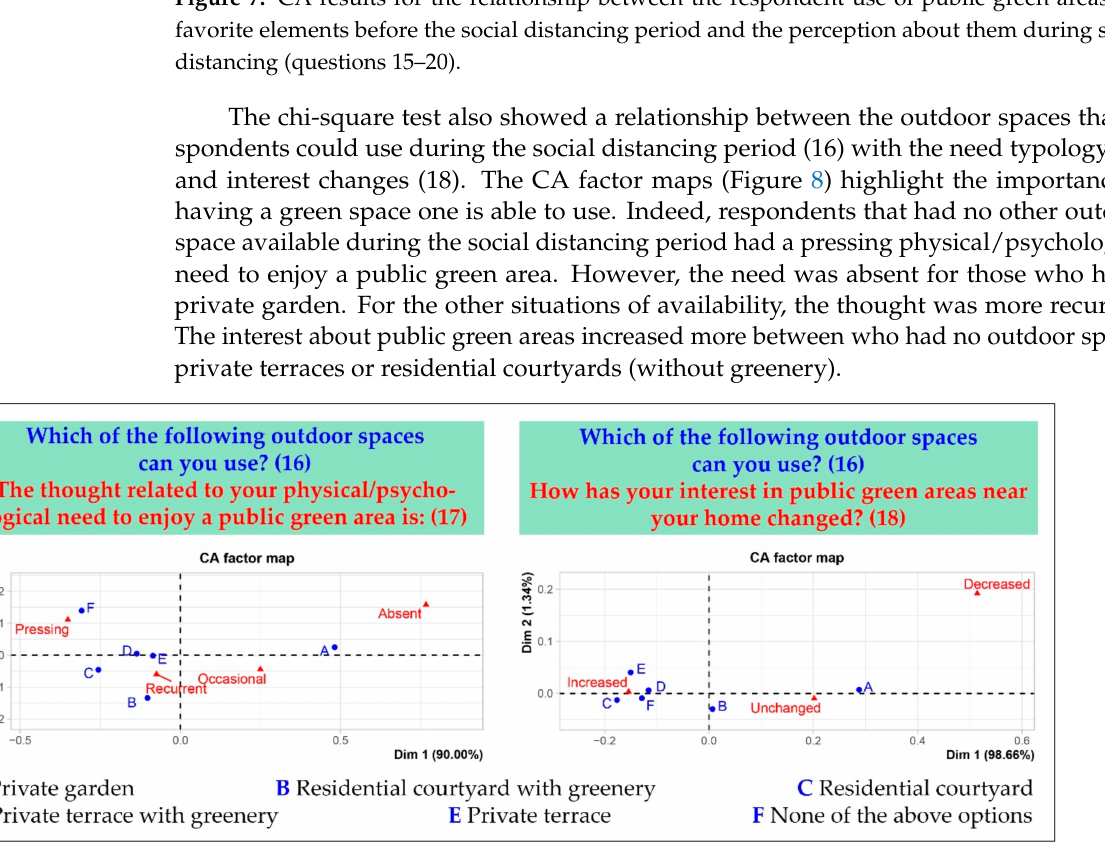
Figure 8. CA results for the relationship between the respondent outdoor space availability and the public green area perceptions during the social distancing period (questions 16–17 and